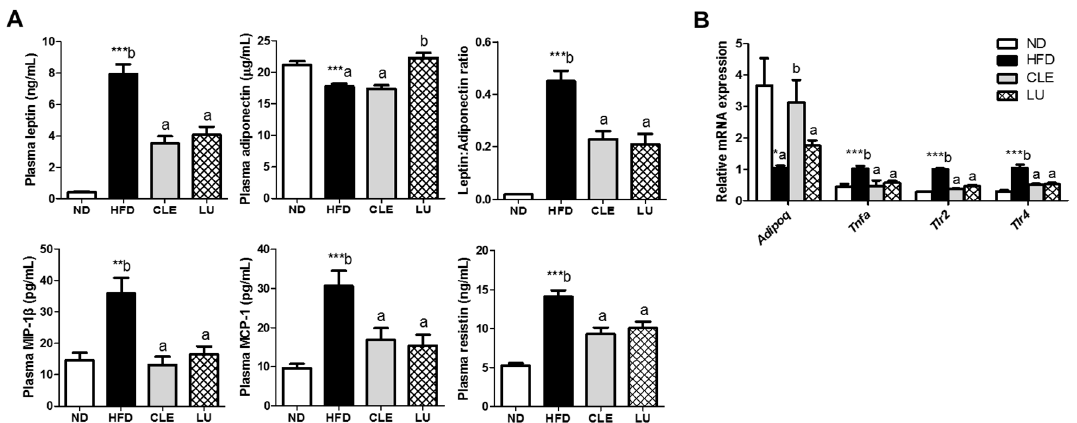
Figure 5. E ff ects of chrysanthemum leaf ethanol extract and luteolin supplements for 16 weeks on inflammation-related markers in C57BL / 6J mice fed a high-fat diet. ( A ) Plasma adipokine and cytokine levels; ( B ) gene expression of adipokine and toll-like receptor genes in epididymal white adipose tissue. Data are mean ± SE. Significant di ff erences between HFD compared to ND are indicated * p < 0.05, ** p < 0.01, *** p < 0.001 (Student’s t -test). ab Means not sharing a common letter are significantly di ff erent among the HFD-fed groups at p < 0.05. ND, normal diet (AIN-76); HFD, high-fat diet (45% kcal from fat); CLE, HFD+chrysanthemum leaf ethanol extract (1.5%, w / w ); LU,